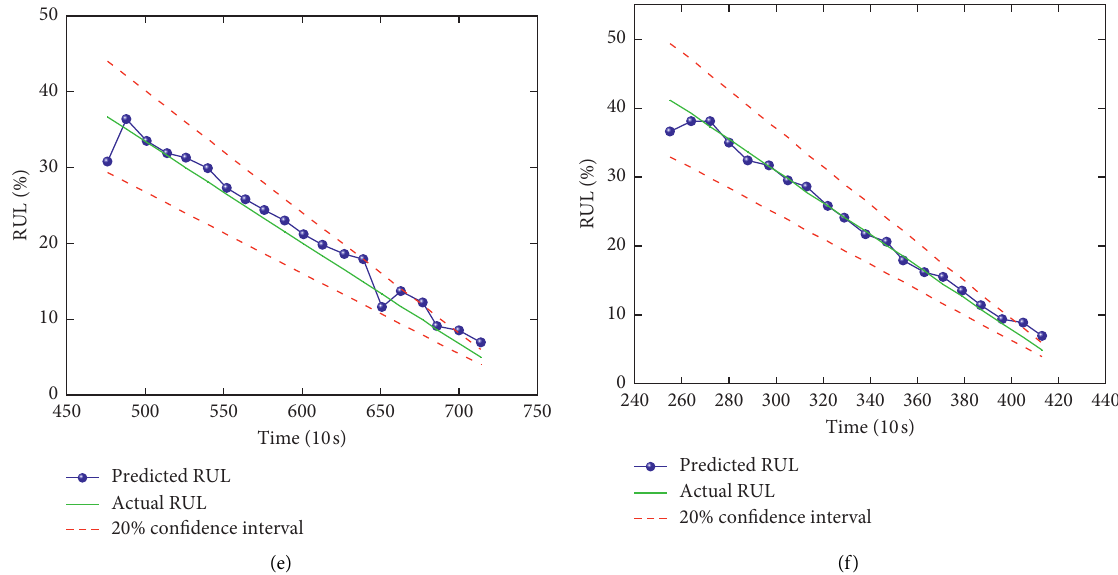
Figure 7: The prognostic performance of the presented approach in terms of the α − λ metric for 6 bearings from different operation